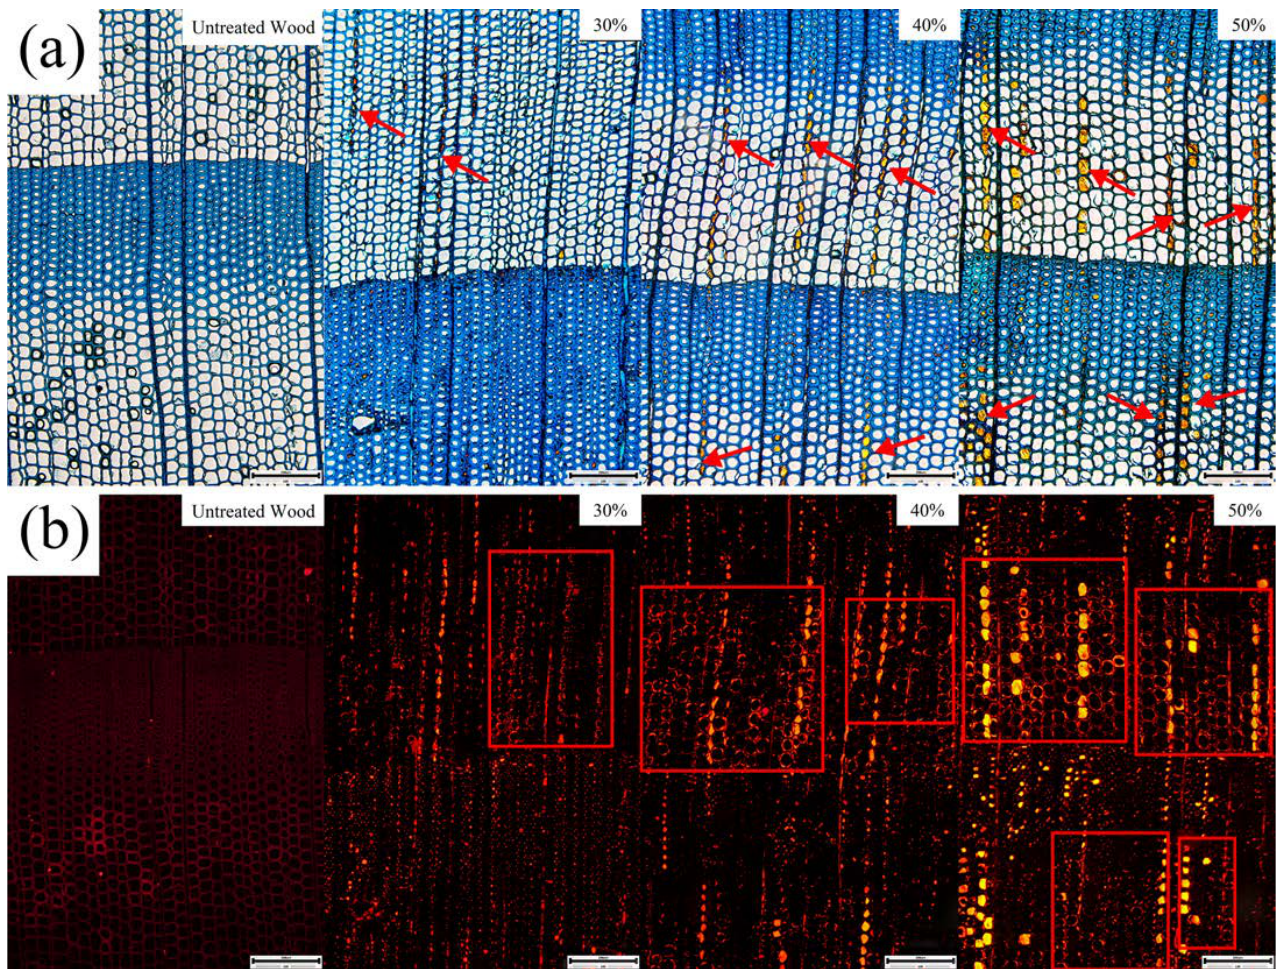
Figure 3. Ordinary ( a ) and fluorescent ( b ) micrographs before and after FA treatment. Red arrows and red squares are the PFA filling areas. and red squares are the PFA filling